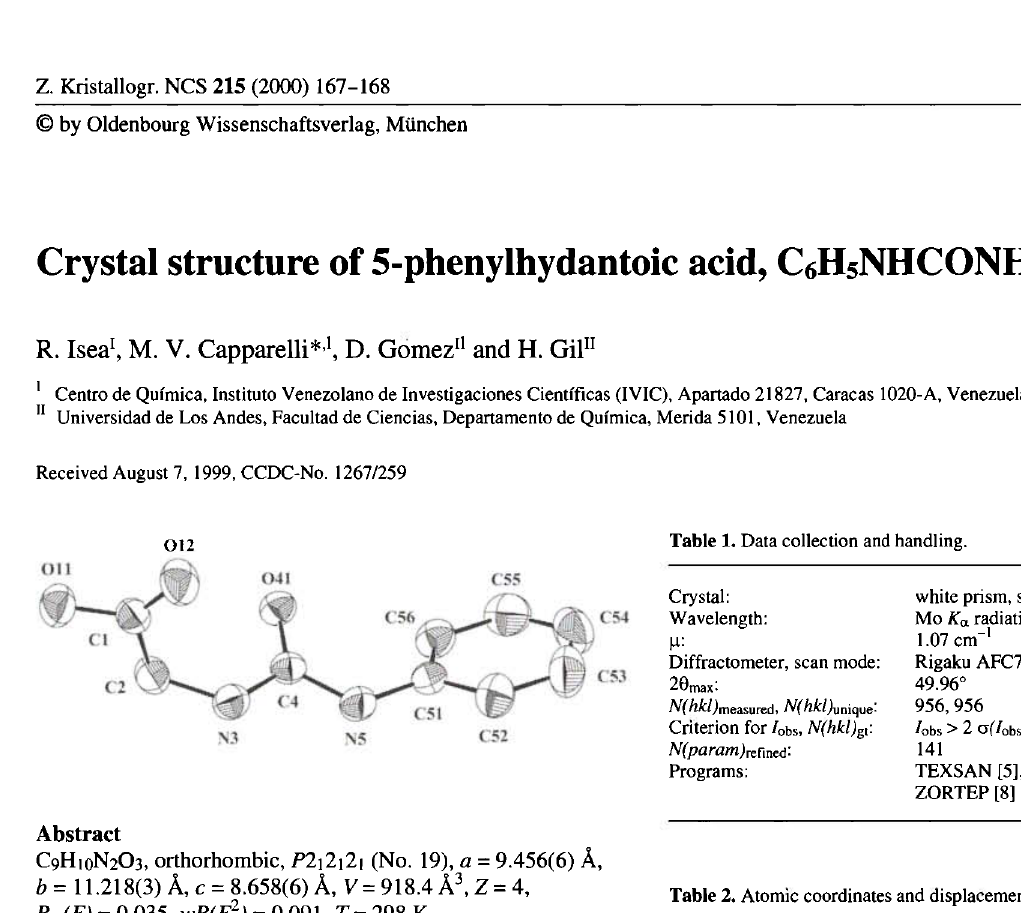
Table 2. Atomic coordinates and displacement parameters (in Ä 2